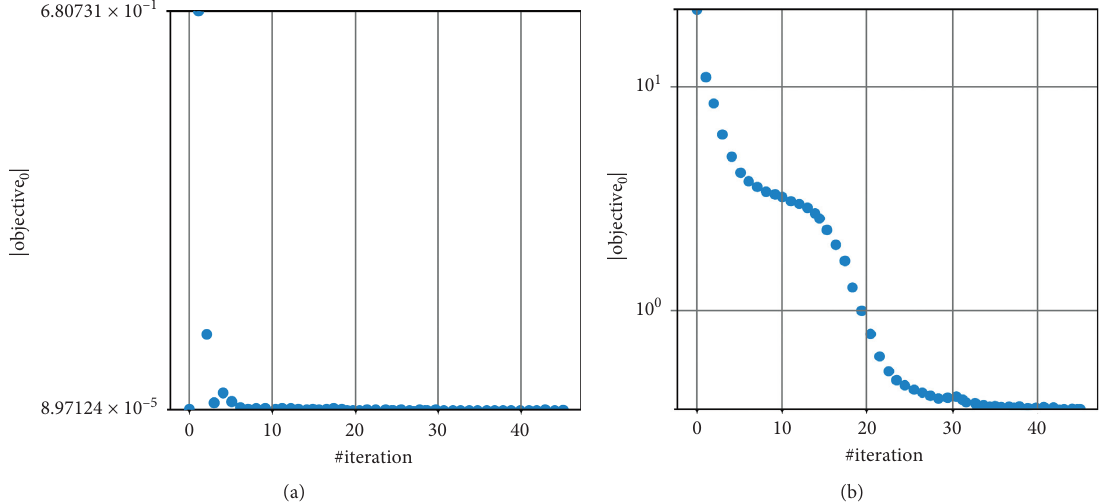
Figure 5: The effect of fine-tuning on the convergence rate of the method. Solving Example 1 with (a) fine-tuning and (b) without